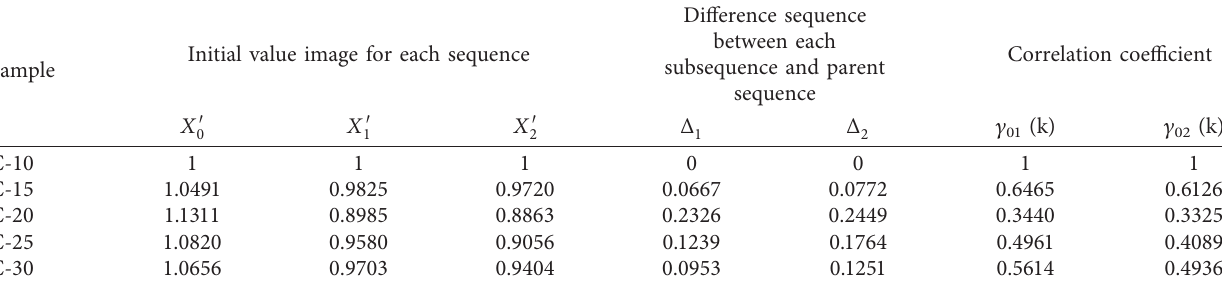
Table 3: Calculated parameters for determining the grey correlation